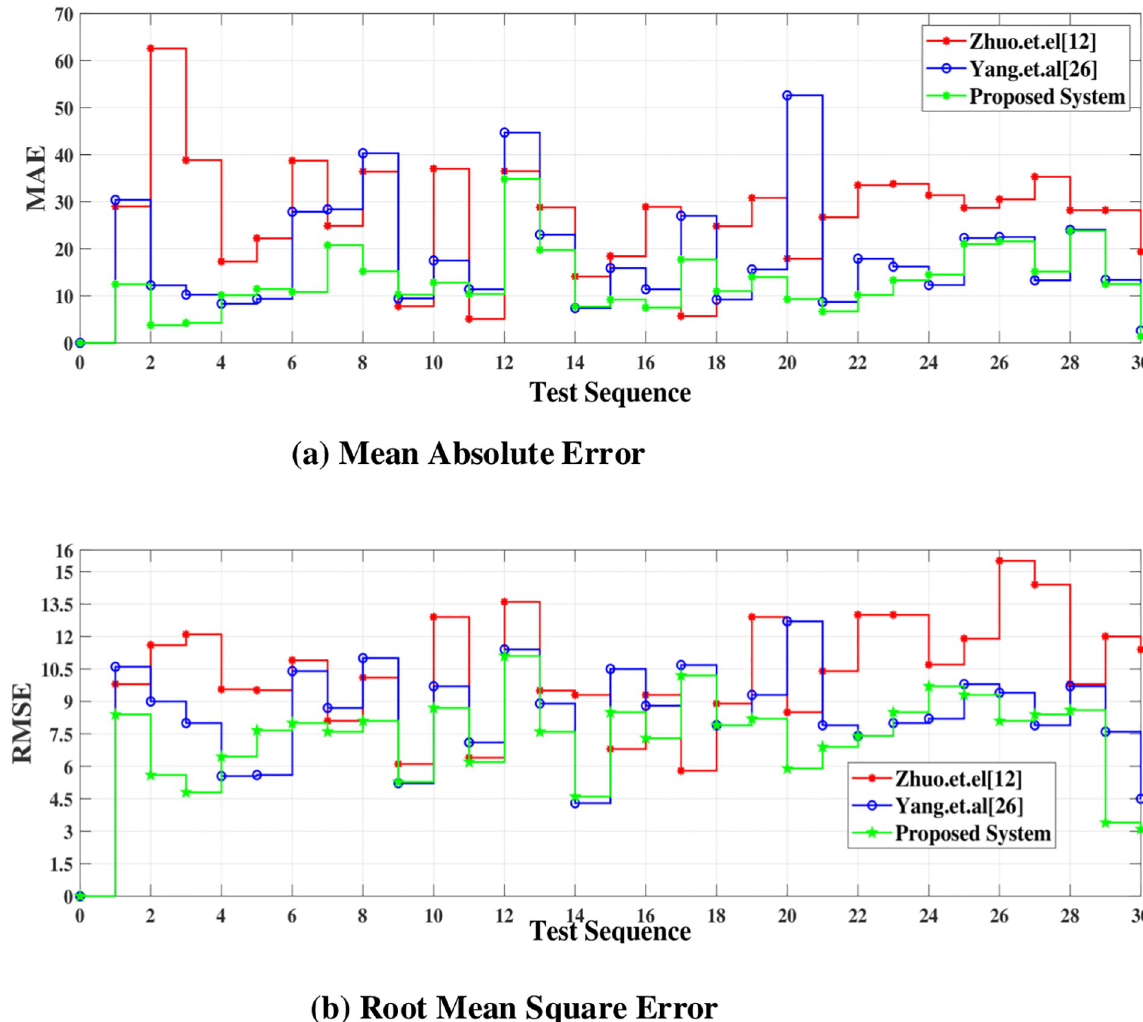
Fig 12. MAE and RMSE of the dataset [37].